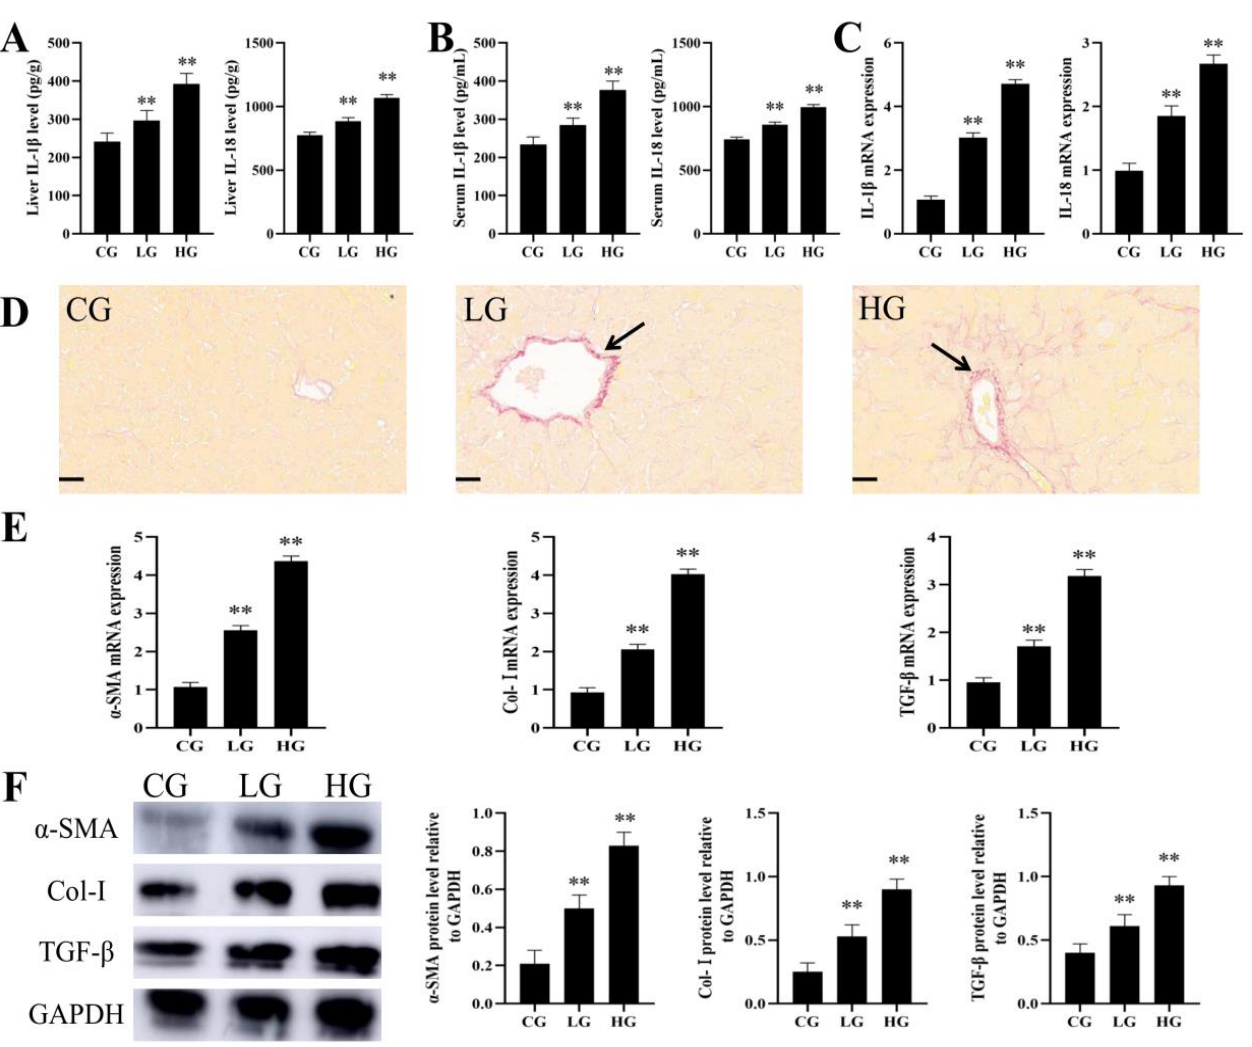
Figure 4. AFB 1 exposure caused liver fibrosis in ducks. ( A ) Liver IL- 1β and IL-18 levels ( n = 6). ( B ) Serum IL- 1β and IL-18 levels ( n = 6). ( C ) mRNA expressions of IL- 1β and IL-18 ( n = 6). ( D ) Representative images of sirius red staining of duck livers (black arrow: fibrotic lesions). ( E ) mRNA expressions of α -SMA, Col- Ⅰ , and TGF- β ( n = 6). ( F ) Western blot analysis of the α -SMA, Col- Ⅰ , and TGF- β protein levels ( n = 3). * p < 0.05 and ** p < 0.01 vs. the CG.